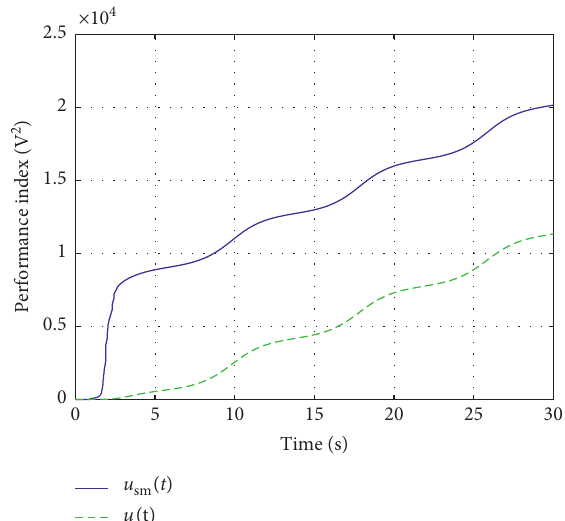
Figure 12: Performance index of the input